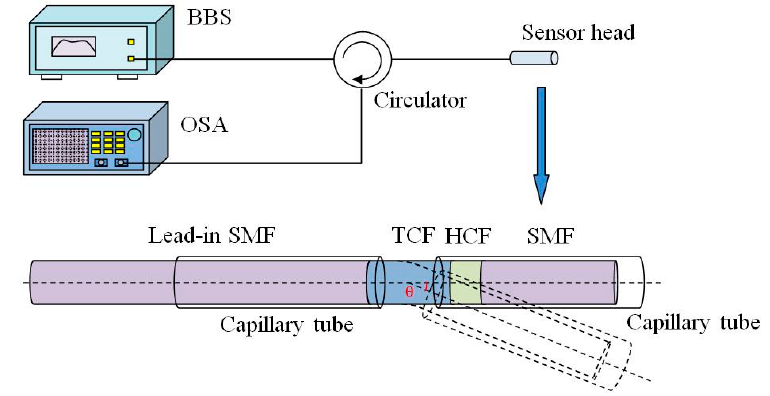
Figure 3. Schematic diagram of the experimental setup for bending angle measurement.